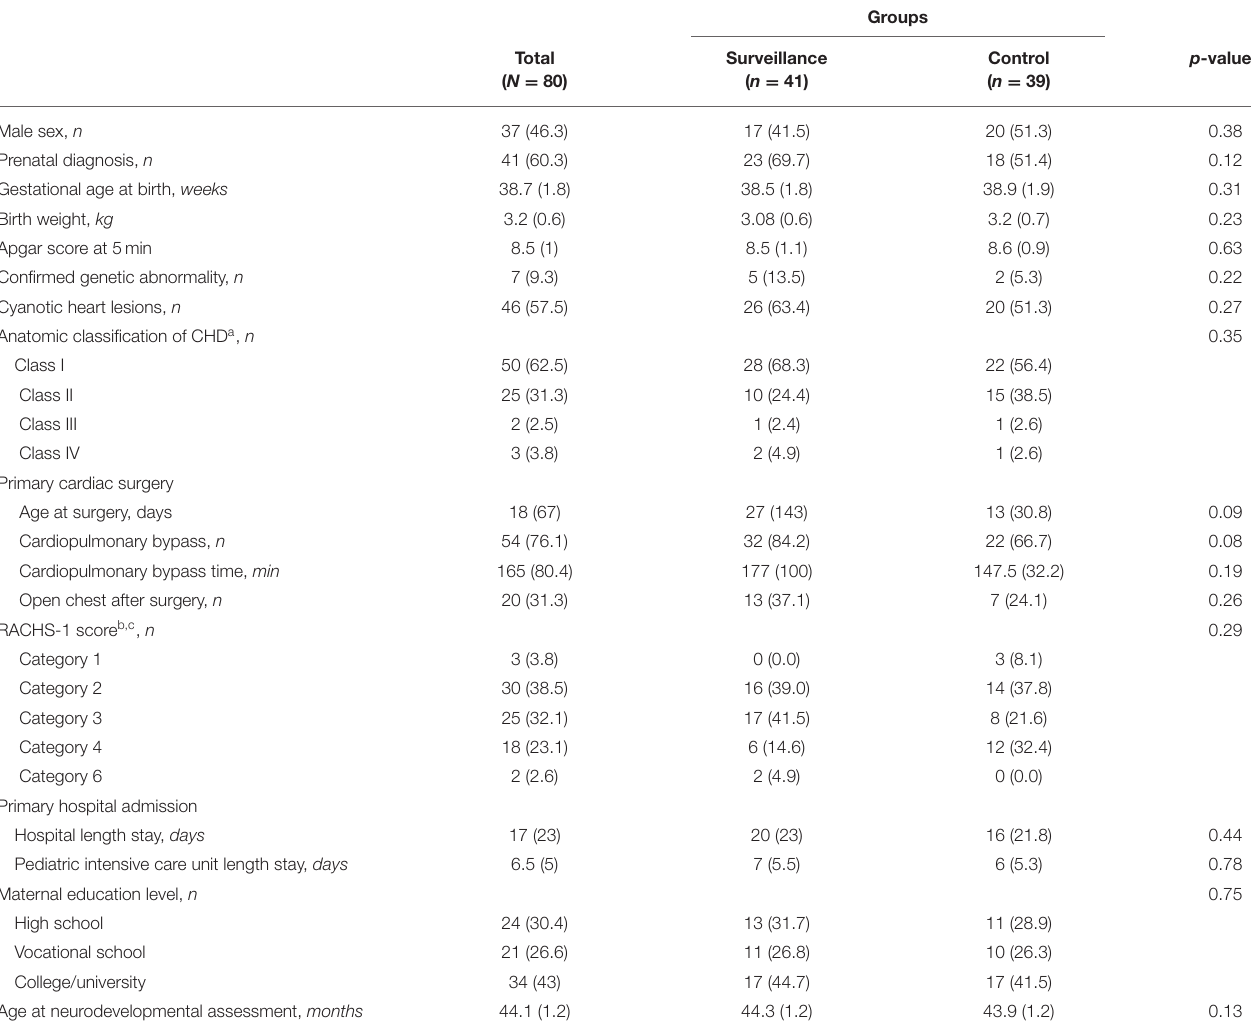
TABLE 1 | Clinical and demographical characteristics of infants with